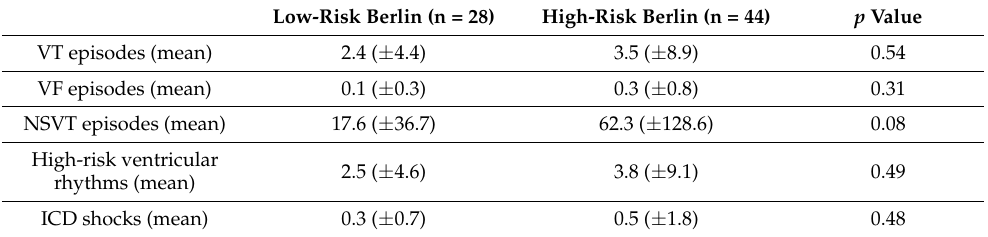
Table 4. Ventricular arrhythmia in AICD subgroup determined by 2-sided t